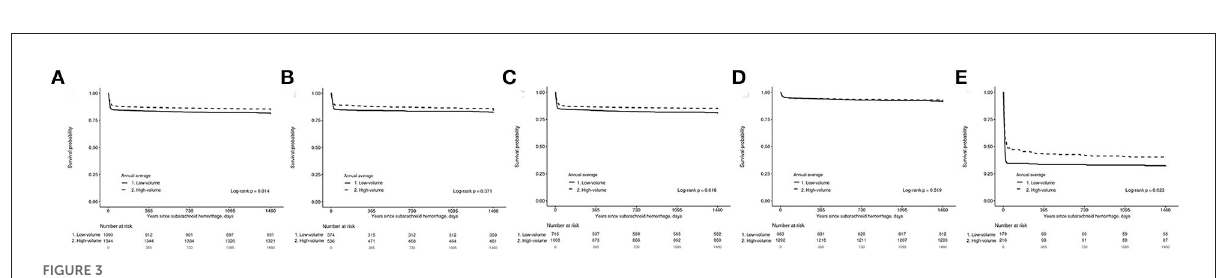
FIGURE3 Kaplan–Meier estimate for survival probability of 2,634 patients with subarachnoid hemorrhage (SAH) treated with clipping and coiling. (A) According to hospital type, (B) 910 patients treated with clipping according to hospital type, (C) 1,724 patients treated with coiling according to hospital type, (D) Mild patients according to hospital type, and (E) Severe patients according to hospital